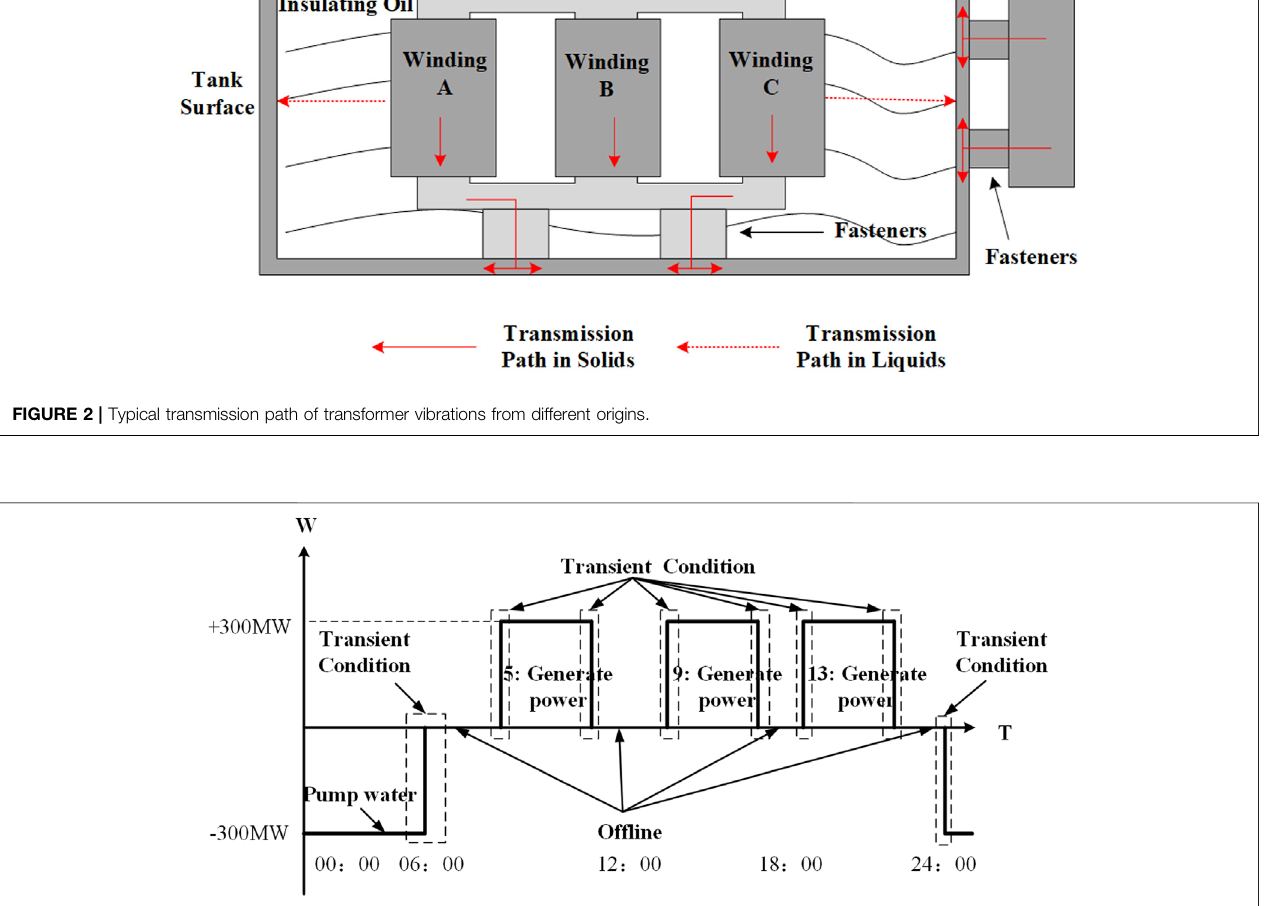
FIGURE 3 | Daily loading conditions for main transformers of